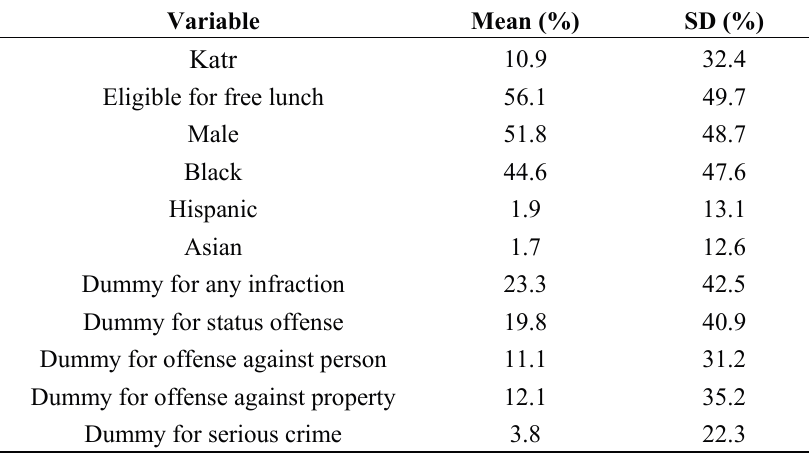
Table 2. Descriptive Statistics of